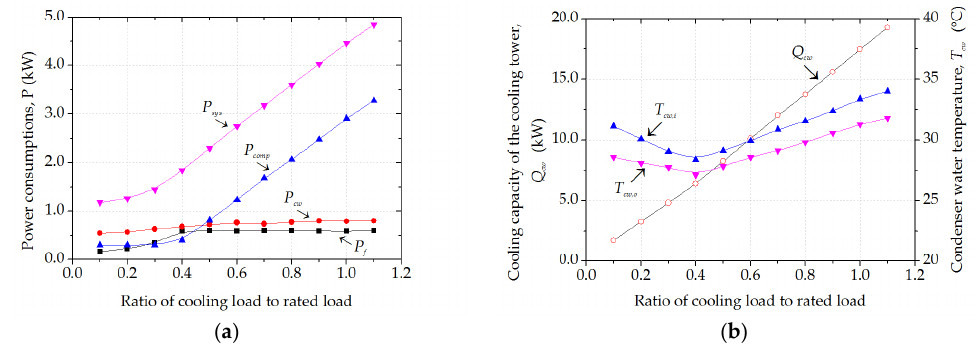
Figure 10. Optimal variables at different ratios of cooling load to rated load: ( a ) minimum power consumptions of the CTAHP system and its optimal controlled variables; ( b ) cooling capacity and condenser water temperatures at the inlet and outlet of the cooling tower.